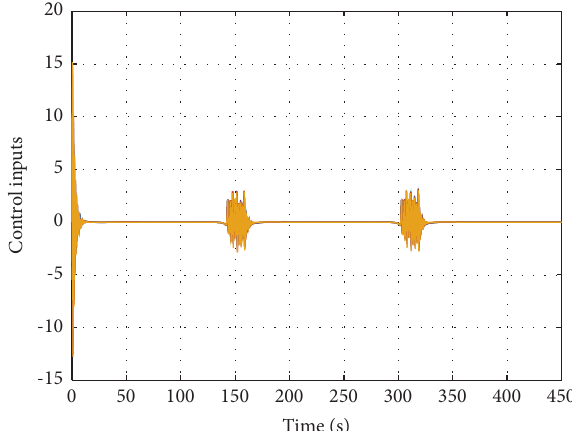
Figure 7: The evolution of the control inputs u